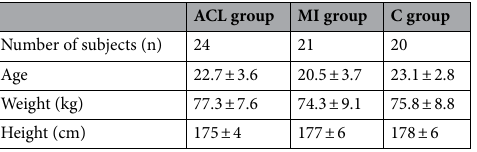
(Table 1). All subjects after ACL reconstruction previously passed the RTS which included: standard orthopedic tests, manual tests performed by a physiotherapist, muscle strength evaluation and hop tests. Inclusion criteria: